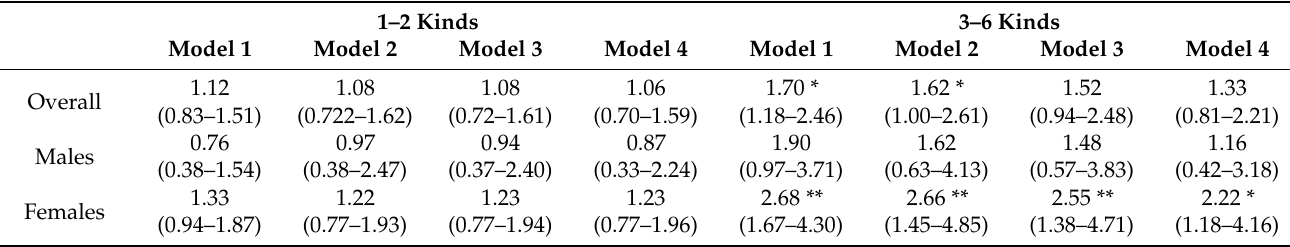
Table 3. Multinominal regression analysis on the association between gender contentedness and sexually explicit media exposures, OR